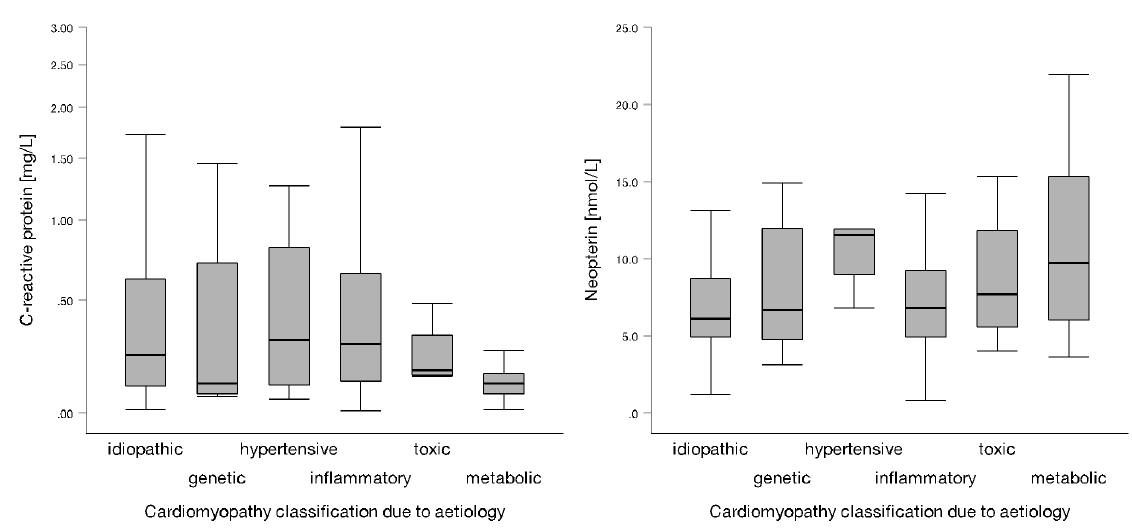
Figure 1: Boxplots of the two inflammatory markers, CRP and Neopterin within the specific CMP aetiologies: medians and ranges are shown. Idiopathic CMP (n = 31), genetic CMP (n = 8), inflammatory CMP (n = 85), toxic CMP (n = 4), metabolic CMP (n =